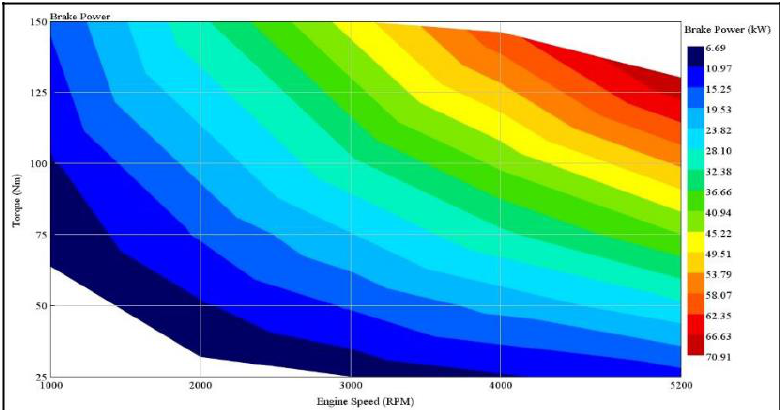
Figure 3. Brake Specific Fuel Consumption (BSFC) model of engine model.